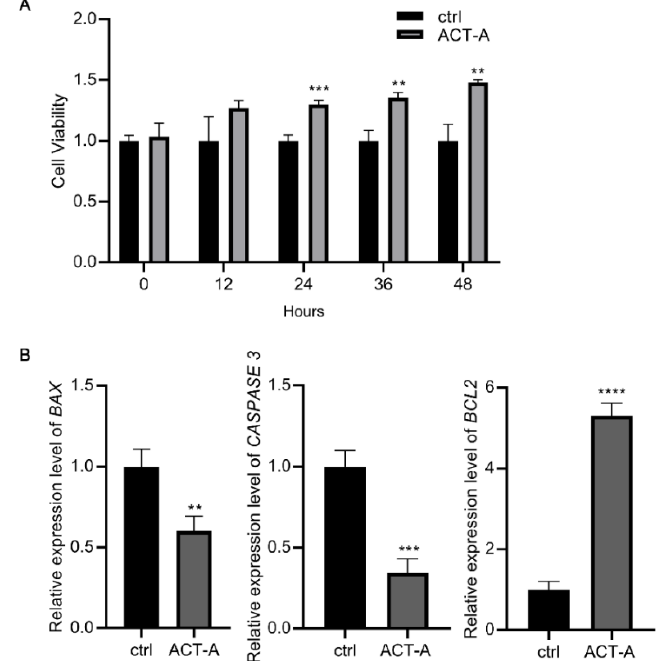
Figure 2. Effect of ACT-A on apoptosis of GCs. ( A ). The CCK-8 test was used to determine how ACT-A affected the apoptosis of GCs. ( B ). Expression of apoptosis-related genes BAX , CASPASE 3 , and BCL2 was assessed using qRT-PCR. ** p < 0.01, *** p < 0.001, **** p < 0.0001.